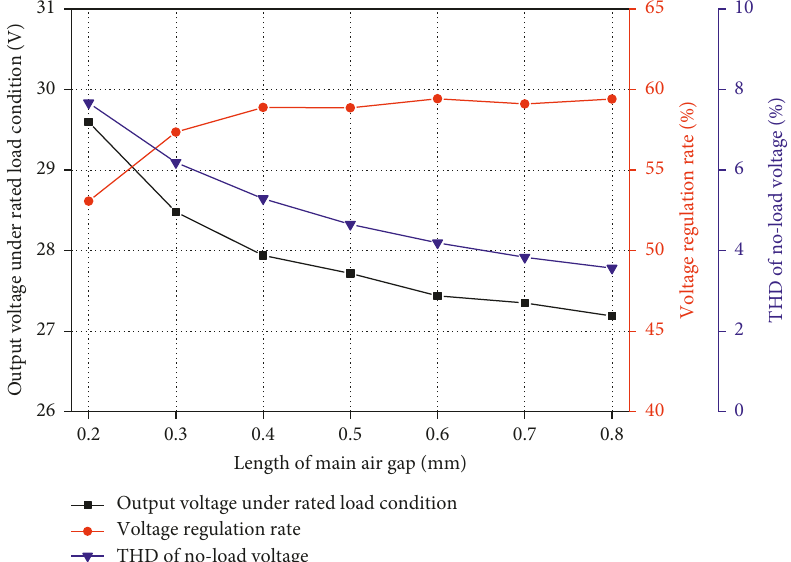
Figure 12: Variation curves of generator output performance with different lengths of the main air gap.